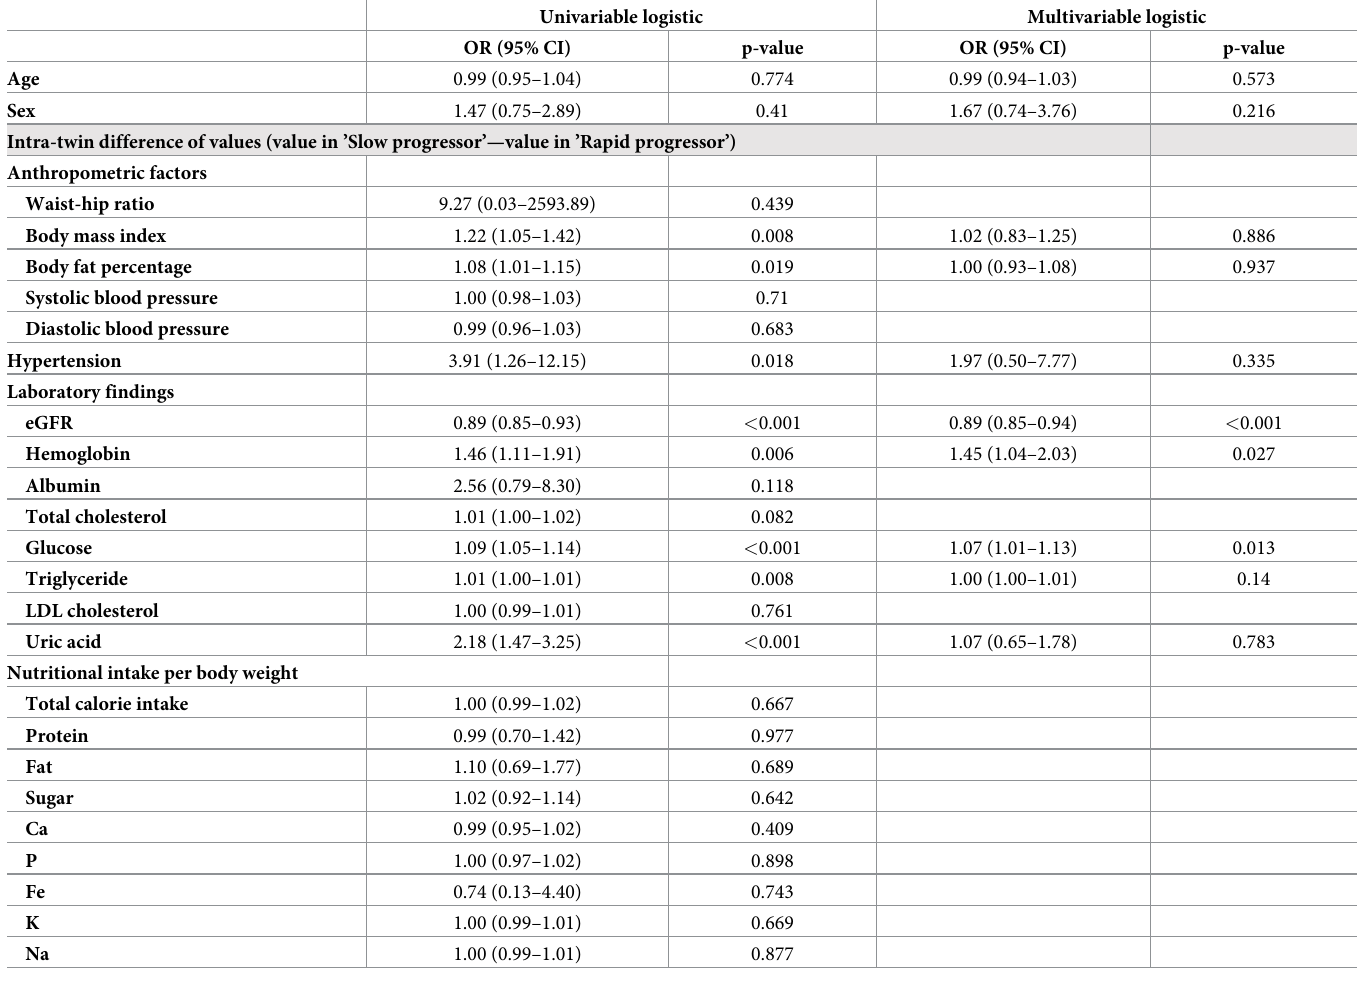
Table 2. Logistic regressions for high discordance twins in eGFR decline rate according to intra-twin difference in each clinical